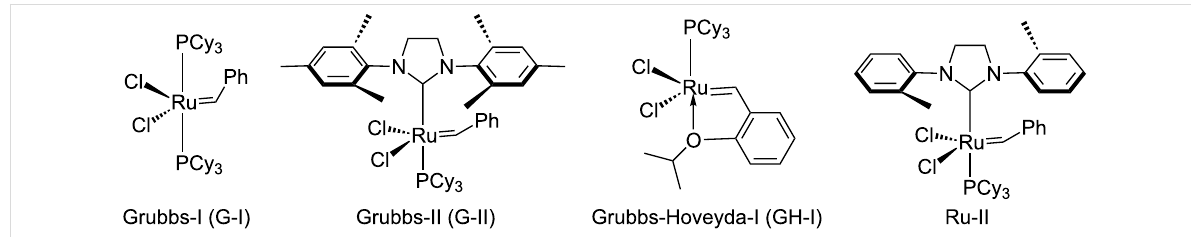
Figure 2: Selected list of ruthenium-based catalysts used for ROM.